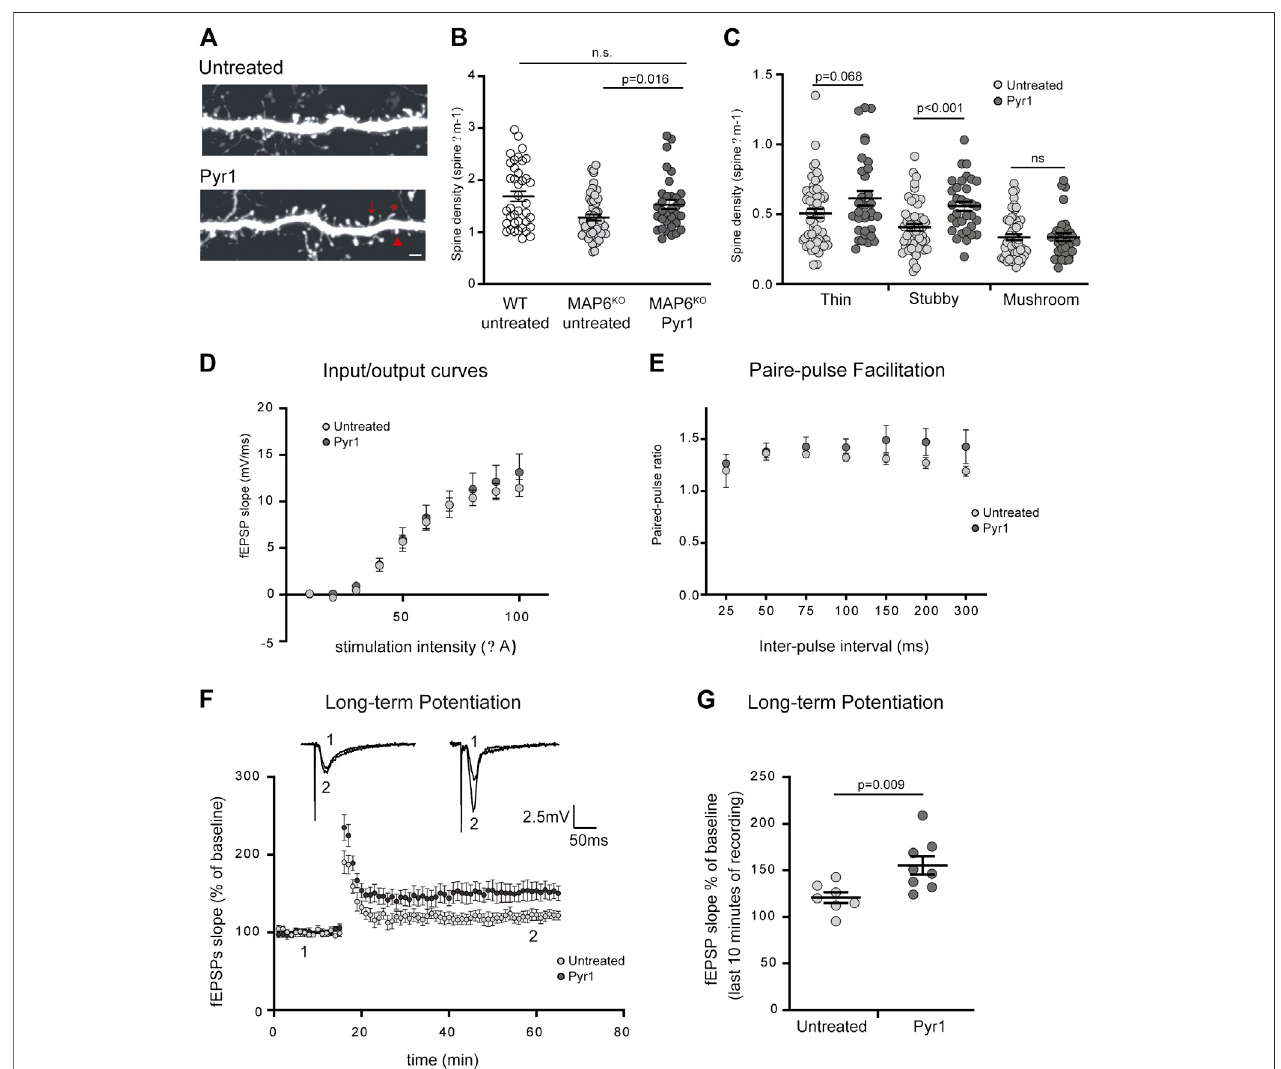
FIGURE 2 | Pyr1 treatment improves defective dendritic spine density and synaptic plasticity in MAP6 KO mice. (A – C) Effect of Pyr1 on dendritic spine density in vivo . Representative confocal images of dendritic segment in MAP6 KO layer V, corresponding to cortical neurons, from untreated or Pyr1-treated (100 mg/kg/week, 6 weeks)mousebrains.Representativespinessub-typesasclassi fi edbyNeuronStudiosoftware,areillustrated:star (cid:2) thinspine,arrowhead (cid:2) stubbyspineandarrow (cid:2) mushroom spine (A) . Scale bar (cid:2) 2 µm. Quanti fi cation of total dendritic spine density. For total spines (B) values were: 1.67 ± 0.10 for WT neurons, 1.25 ± 0.06 and 1.51 ± 0.09 spines/µm for untreated MAP6 KO and Pyr1-treated MAP6 KO neurons, respectively. For classi fi ed spines (C) densities were: 0.51 ± 0.03 and 0.61 ± 0.05 thin spines/µm; 0.40 ± 0.02 and 0.55 ± 0.03 stubby spines/µm; 0.33 ± 0.02 and 0.34 ± 0.03 mushroom-like spines/µm, for untreated and Pyr1-treated neurons, respectively. Values correspond to mean ± SEM. Student ’ s t-test p values are indicated. ns: not signi fi cant. n (cid:2) 39 neurons from four WT mice, n (cid:2) 52 neurons from six untreated mice, and n (cid:2) 33 neurons from four Pyr1-treated. One to two neurites were measured for each neuron, total length ≥ 50 µm (D – G) Effect of Pyr1 on hippocampal synaptic transmission and plasticity in MAP6 KO mice (D) Basal synaptic transmission analyzed based on input-output curves generated by plotting Field EPSPslopeagainststimulationintensity.RecordingswereperformedinbrainslicesfromuntreatedandPyr1-treatedmice. n (cid:2) 5slicesfromfouruntreatedandfourPyr1- treated mice. (E) Short-term plasticity was monitored by measuring the Paired-Pulse Facilitation (PPF). Seven distinct inter-pulse intervals ranging from 25 to 300 ms in slices were used to measure paired-pulse ratios in slices from untreated and Pyr1-treated mice. n (cid:2) 5 slices each from four untreated and four Pyr1-treated mice (F – G) Long-TermPotentiation(LTP)wasassayedintheCA1 region (F) fEPSP slopesexpressed asapercentage ofbaseline wereplottedagainst time foruntreated and Pyr1- treatedbrainslices.RepresentativefEPSPtraceswereextractedattimes1and2,asindicated (G) fEPSPslopesmeasuredoverthelast10 minofrecordings,expressed as a percentage of the baseline fEPSP slope (120.8% ± 5.9 and 155.5% ± 9.8 for untreated and Pyr1-treated mice, respectively). Values correspond to mean ± SEM. Mann-Whitney test, p value is indicated. n (cid:2) 7 slices from three untreated mice and n (cid:2) 8 slices from fi ve Pyr1-treated mice.